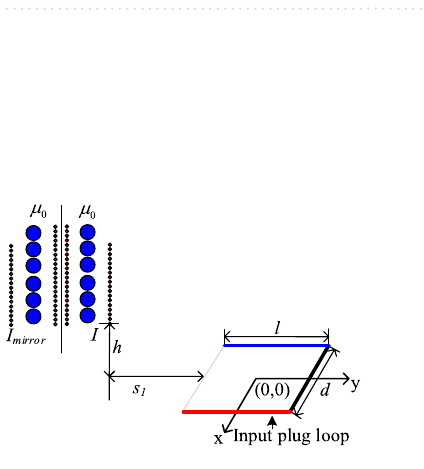
Figure 10. Derivation process of transformer model: ( a ) coupling between transformer and plug; ( b ) xoy plane view of transformer and plug; ( c ) ideal Equivalent of; ( d ) coupling calculation model.